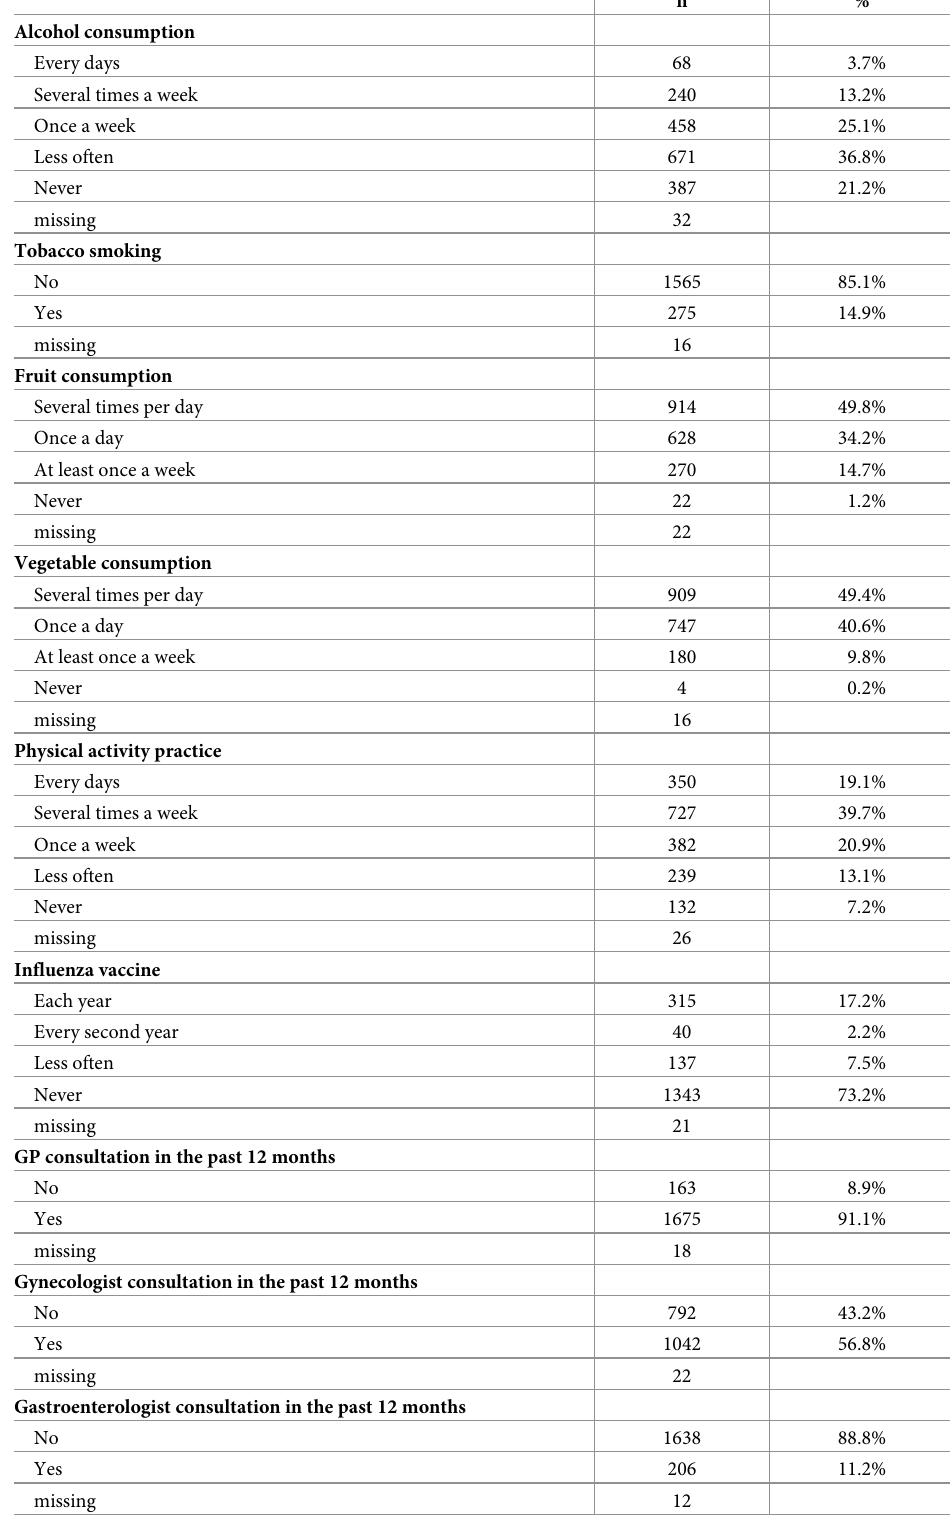
Table 2. Health behaviors characteristics of the